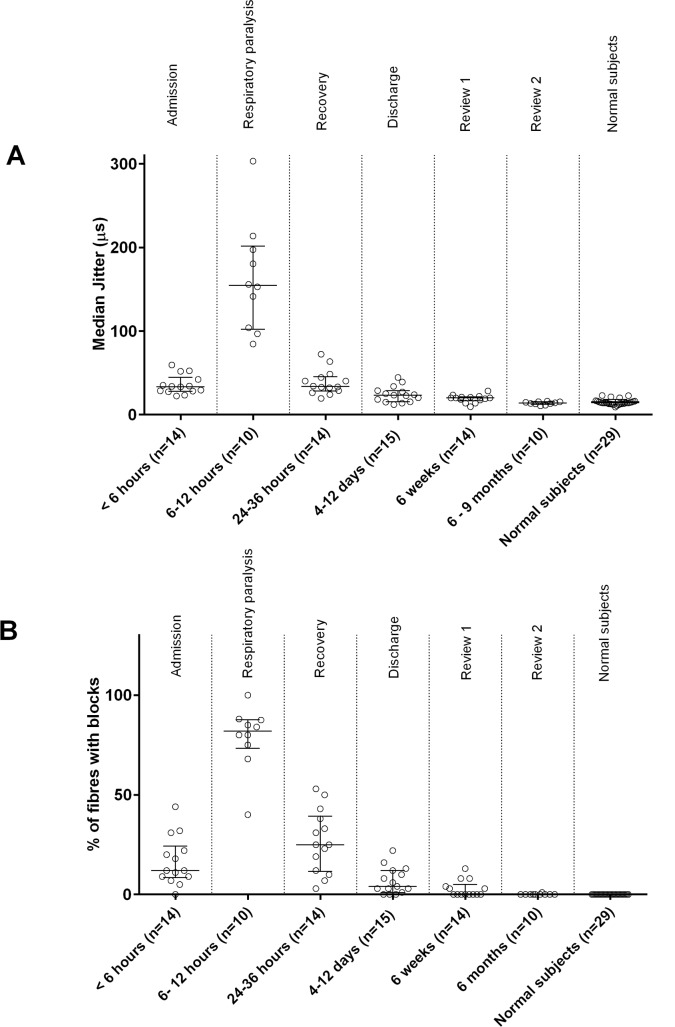
Time related change of sfEMG jitter and blocks in patients developed severe neurotoxicity.A, Scatter plots showing the time related change of the median MCD in jitter of the 17 patients with severe neurotoxicity, compared to normal subjects. Note the high median of the MCD in jitter values seen even at 6 weeks after the snakebite, compared to the normal subjects; B, scatter plots showing time related changes in the percentage of recorded fibres with neuromuscular blocks in these patients at the same times. Neuromuscular blocks are still present 6 weeks after the snakebite.